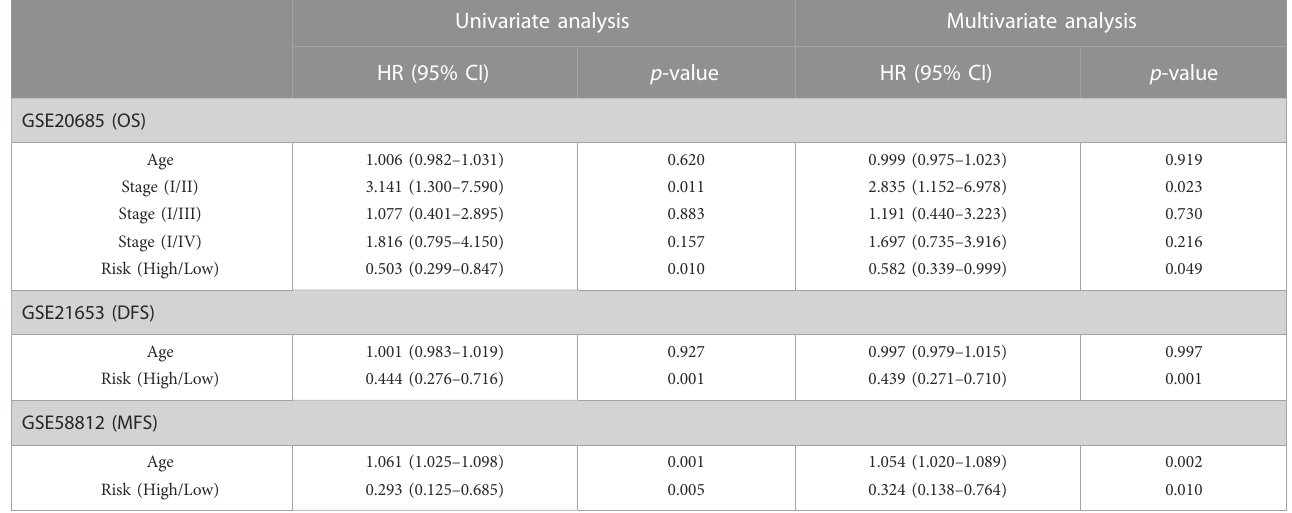
TABLE 2 Univariate and multivariate Cox regression analysis of clinical characteristics and survival of BC patients in Validation set